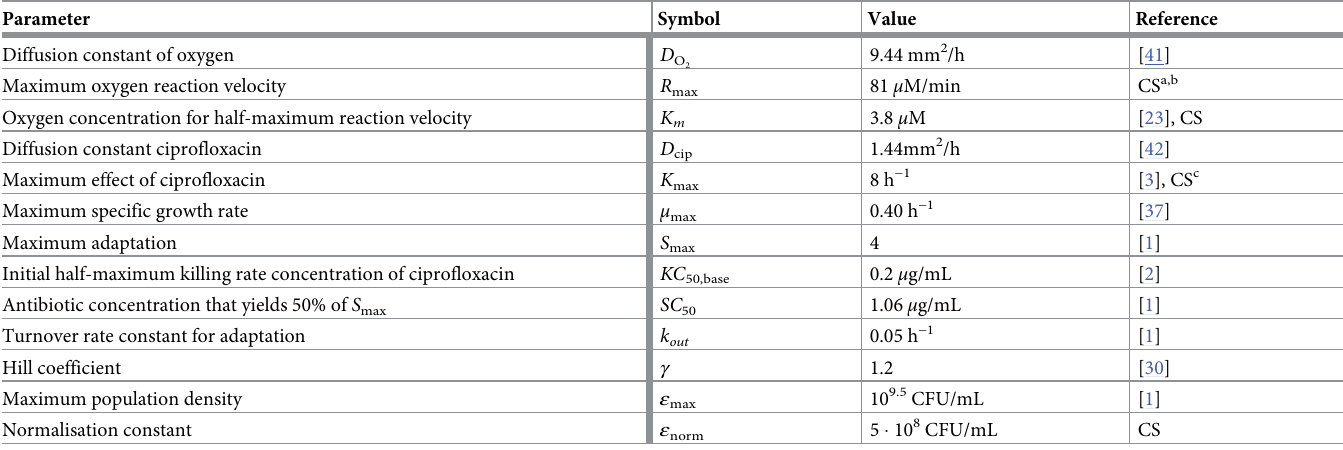
Table 1. Parameter values used for simulation of the oxygen and ciprofloxacin models.